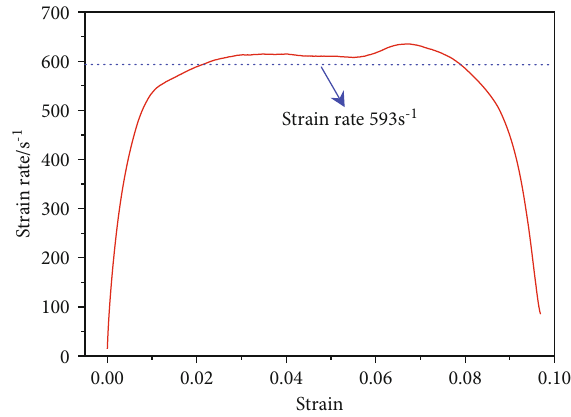
Figure 3: The typical strain rate time history